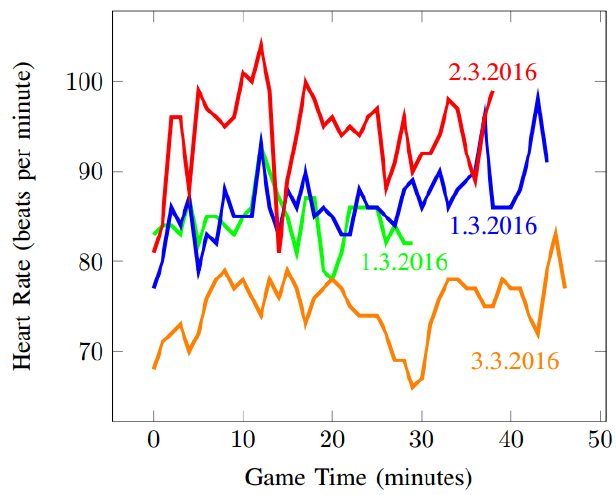
Figure 2. Heart rate during four games of Dota 2, played by the test subject in three sessions.